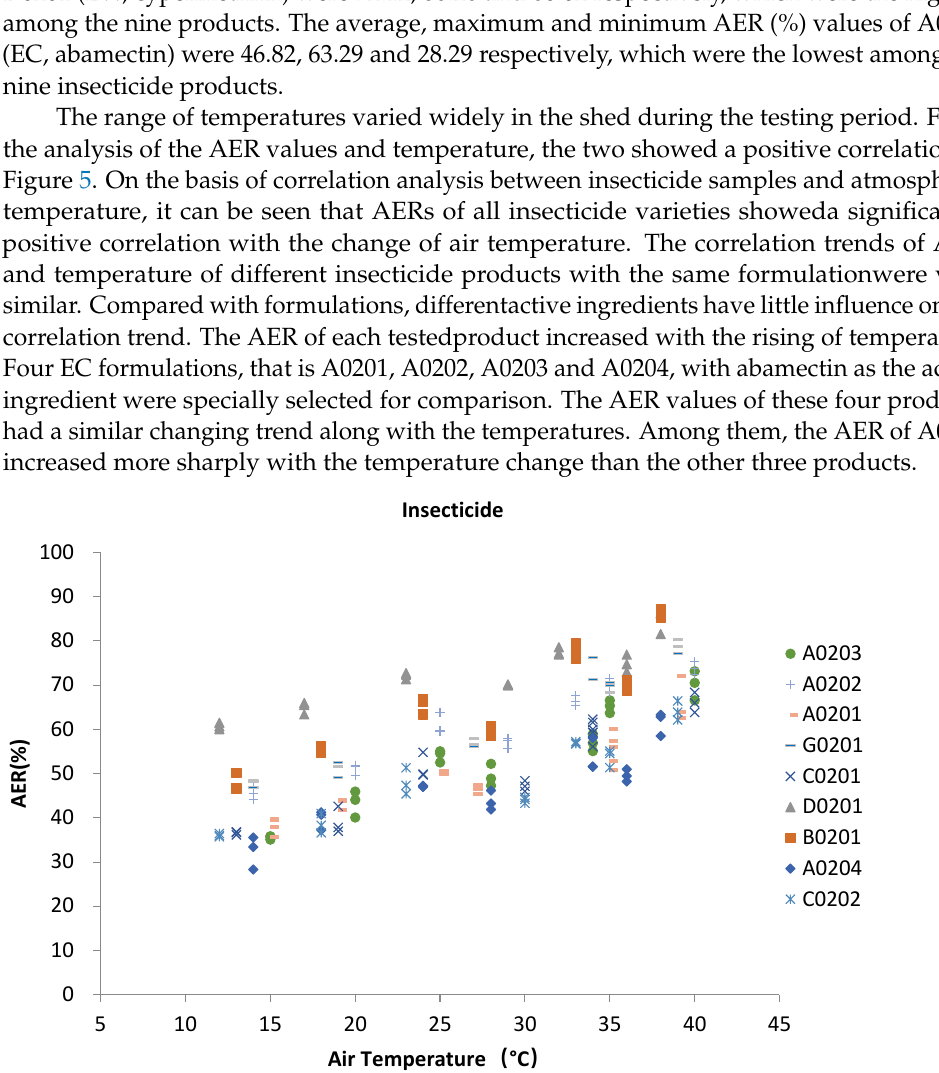
Figure 5. Relationship between AER of insecticide and air temperature.